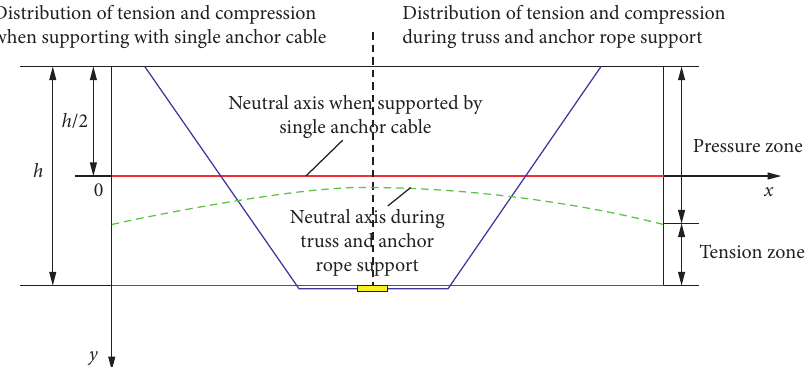
Figure 7: Computational mechanics model of the neutral axis in the anchorage zone